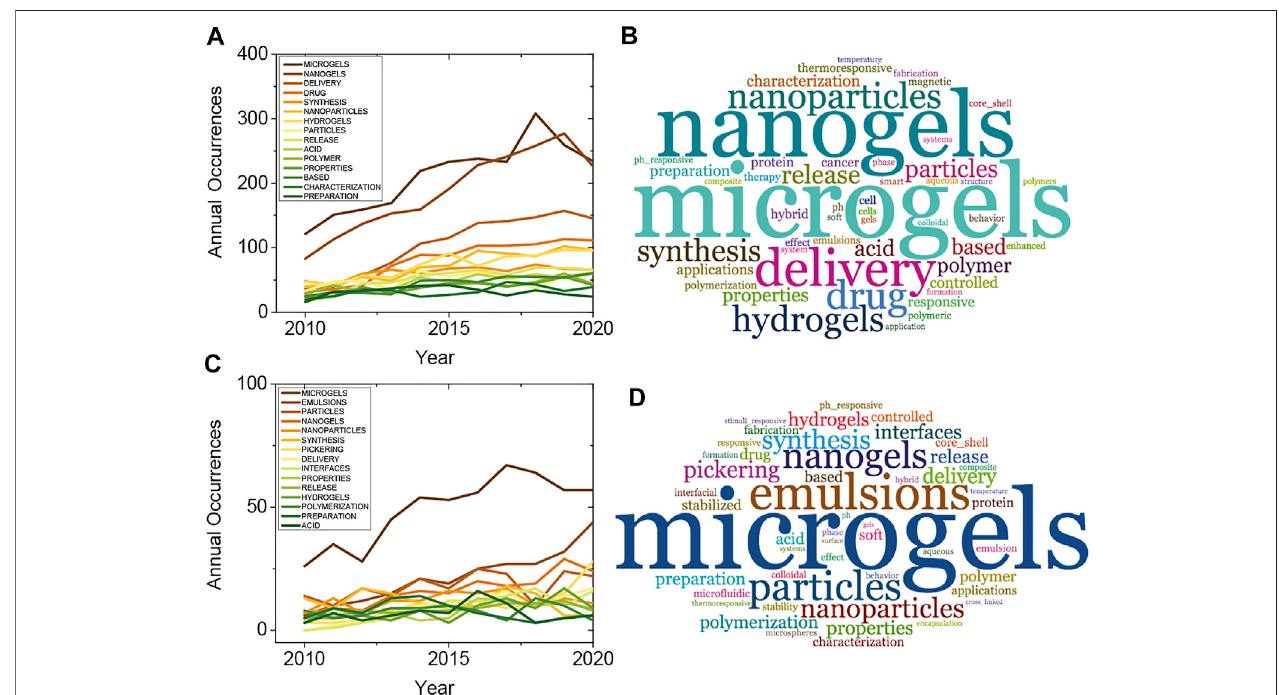
FIGURE 2 | Bibliographic word-counting analysis between the years 2010 – 2020. Annual occurrences of words and word-cloud for the topic “ microgels and nanogels ” (top) and “ microgelsandnanogelsatinterfacesandemulsions ” (bottom) using (A,C) worddynamicsrepresentingtheannualcountforthe15mostrepeated words. (B, D) word-cloud analysis representing the 50 most repeated words in the titles of the bibliography items.